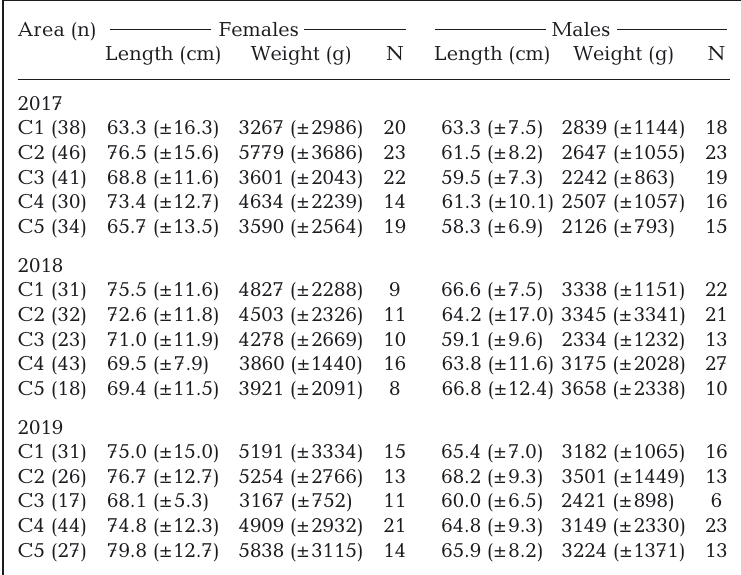
Table 1. Physical data for the acoustically tagged mature, sexed cod in the 5 different clusters (C1−C5) yielding data for the present study. Values are average (±SD) total length and weight for males and females and number (N)